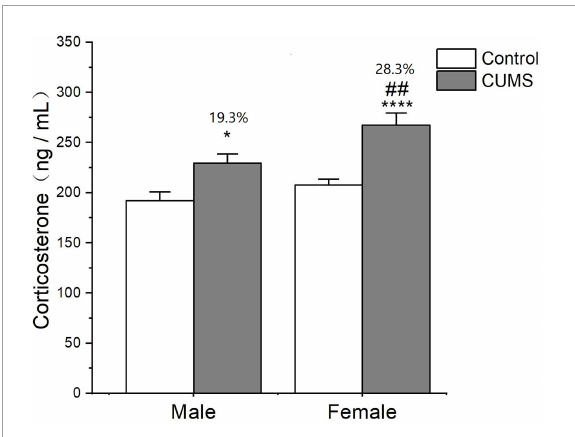
FIGURE6 CUMS increased the level of corticosterone in male and female rats. * p < 0.05, **** p < 0.0001 vs. control with same sex, ## p < 0.01 vs. male stress